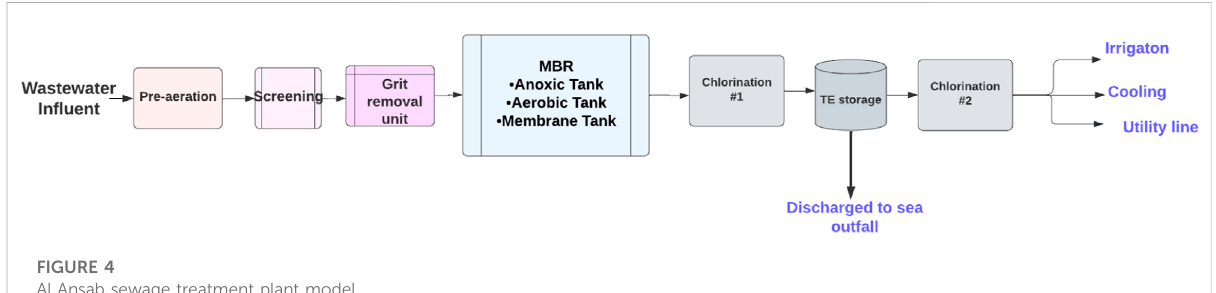
FIGURE 4 Al Ansab sewage treatment plant